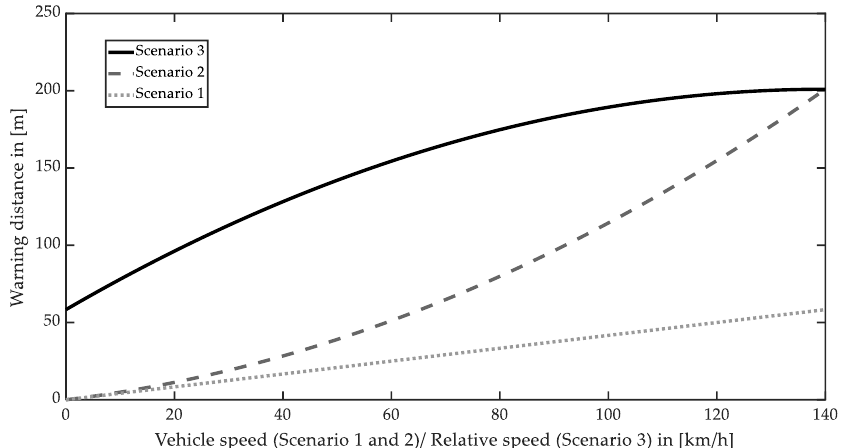
Figure 2. Warning distance as a function of the subject vehicle speed or relative speed for three typical scenarios; subject vehicle speed for scenario 3 is 140 km∙h − 1 .